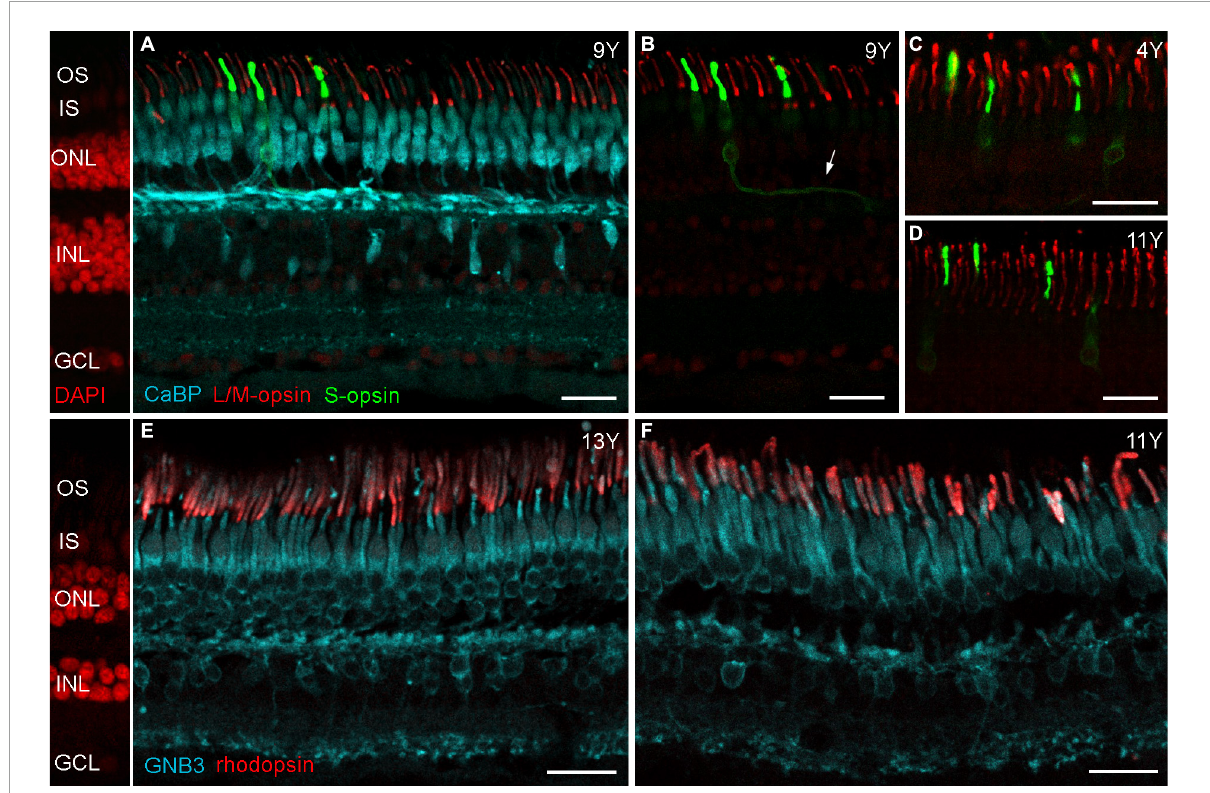
FIGURE2 Opsin localization in aged marmoset retina. (A) Triple immunolabeling of calbindin, L/M-opsin and S-opsin shows that L/M-opsin expression is restricted to the outer segments of red and green cones. S-opsin is strongly expressed in outer segments, but also weakly expressed in inner segments and cell bodies of blue cones in both control (C) and aged marmosets (B,D) . The cutout in (B) shows the same labeled cones as in (A) , but without calbindin staining. The arrow points to a labeled blue cone axon. (E,F) Double labeling of GNB3 and rhodopsin shows no sign of opsin mislocalization: rhodopsin is only visible in the outer segments of rods. OS, outer segments; IS, inner segments; ONL, outer nuclear layer; INL, inner nuclear layer; GCL, ganglion cell layer. Scale bars, 25 µ